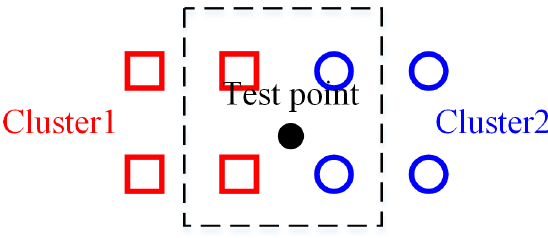
Figure 2. Test point in the middle of two adjacent clusters.